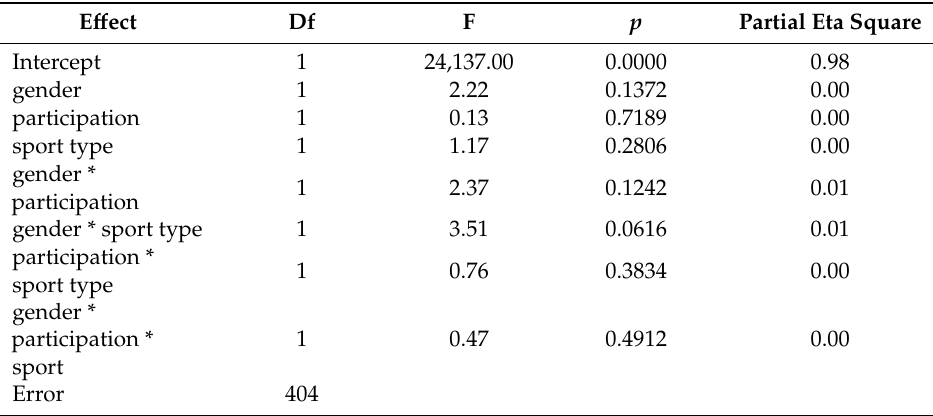
Table 7. Three-way ANOVA summary for the POSQ task subscale.